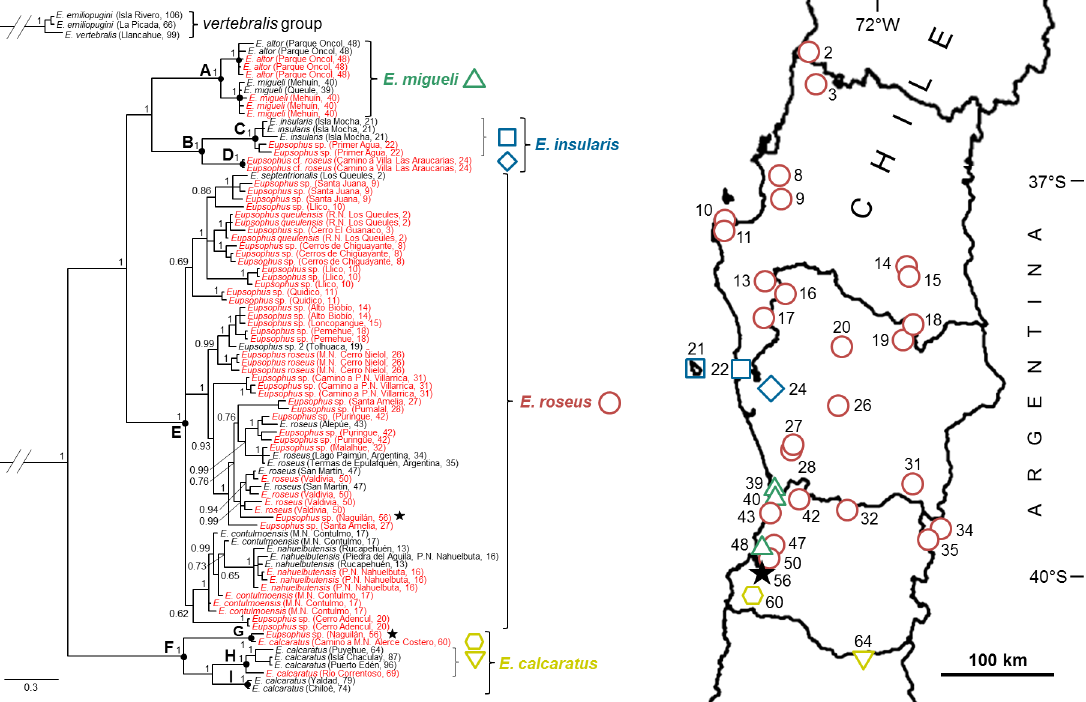
Fig 3. Bayesianconsensus tree showing the relationships among the nominal species of Eupsophus and new populations of the roseus group. The tree was simplifiedby deletingthe outgroup( Alsodesbarrioi )and shortening the more basal branches(indicatedby parallellines). Samples in red correspond to the specimensadded in this study. Numbers along the nodes indicateposterior probabilityvalues. The scale bar belowthe tree represents the expectedsubstitutionsper site. Nodes labeledA, C, D, E, G, H, and I indicate the seven candidate species obtained with mPTP and relaxed ABGD analyses(Fig 4); the map on the right shows with different colored symbols the localitiescorrespondingto six of these seven lineages(clade I distributes further south, out of the map). Nodes A, B, E, and F correspondto the result of the conservative ABGD analysis, which is our favored estimate of speciesof the roseus group (localitiesof the four speciesdepicted with the same colors of the Fig 4). The black stars in the tree indicate the samplesof E . roseus and E . calcaratus (as identifiedhere) found in syntopy (Naguila´n, locality indicatedby the star in the map). Dark lines within Chile representboundariesof Administrative